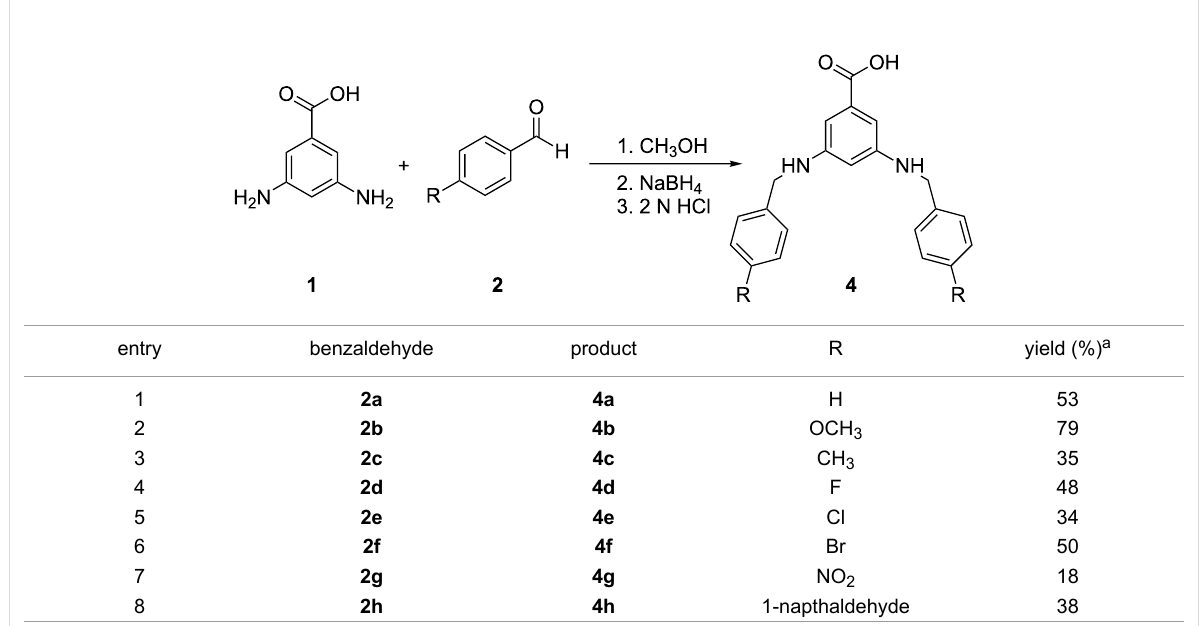
Table 2: Formation of bisamine compounds 4a – h